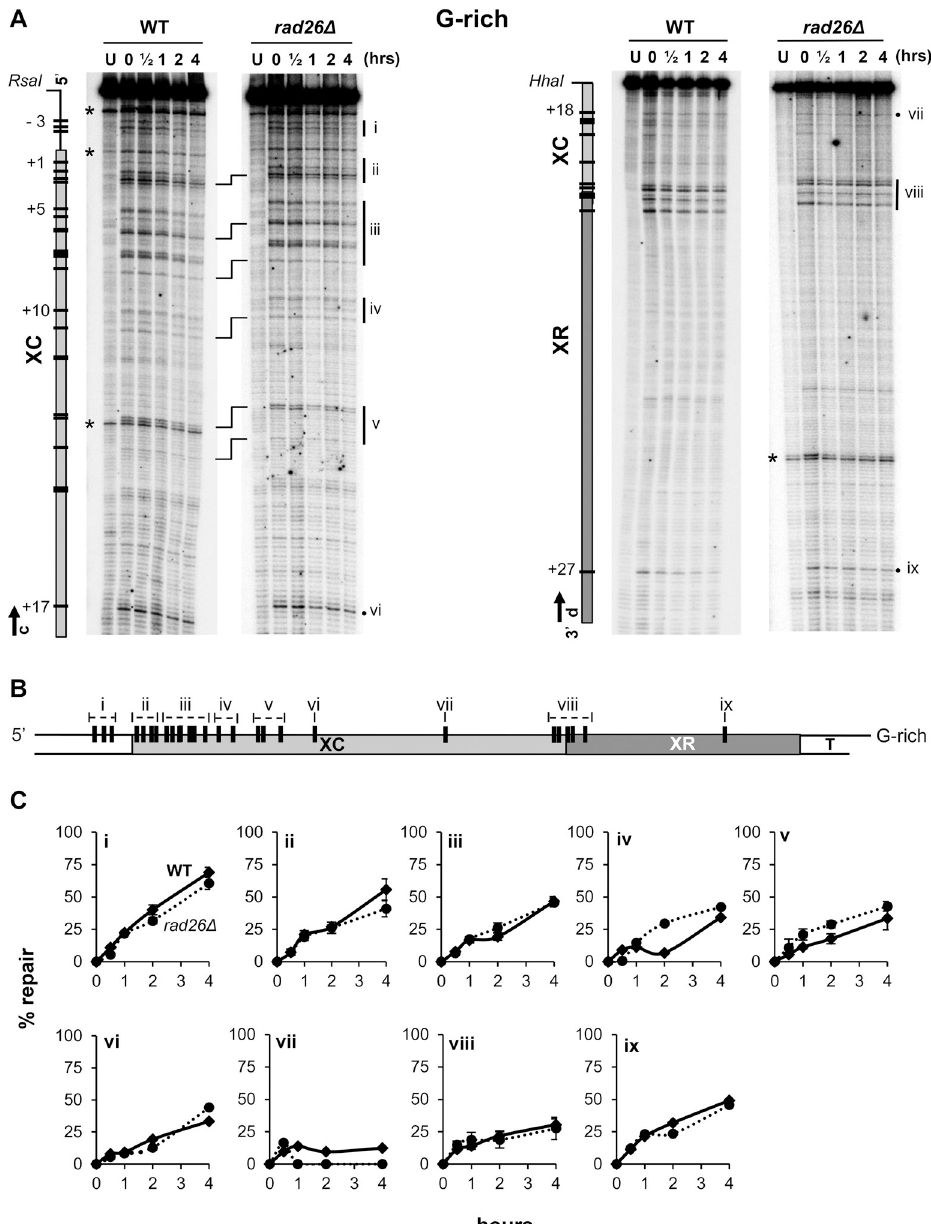
Fig 3. Repair of pyrimidine dimers in the Tel15L X-element of WT and rad26 Δ cells, G-rich strand. Yeast were UV irradiated at 180 J/m 2 and harvested after 0, 0.5, 1, 2 and 4 hours (hrs). Isolated DNA from non-irradiated (U) and irradiated cells (0 to 4 hrs) were digested with RsaI or HhaI and used as template for TaqI polymerase primer- extension. (A) Repair of PDs was assessed by the extension of primers ‘c’ and ‘d’ (arrows) ( S2 Table ). Maps on the left of sequencing gels are of the X-element with the 5’- and 3’- ends, its XC- (light gray) and XR- (dark gray) regions, and flanking DNA (line). PDs that were quantified and plotted in S4 and S5 Figs are represented by black bars and numbered negatively or positively when present outside or inside of the X-element, respectively. The position of PDs was verified by DNA sequencing lanes (not included in the figure). Asterisks point to natural sequences causing TaqI polymerase arrest, brackets align bands between gels and vertical bars mark PD clusters (‘i’ to ‘ix’). (B) General map of the X-element (~730 bp) with the position of PDs (black bars) that approximatively reproduce the migration of bands in the gels. (C) Repair plots (percent of repair over time) are for clusters of PDs (‘i’ to ‘ix’); WT (diamond, continuous line) and rad26 Δ (circle, dotted line). The means ± 1SE are for clusters of at least 3 PDs. P -values were calculated using a 2way ANOVA test using a Sˇı´da´k’s multiple comparisons test. P -values show no significant statistical